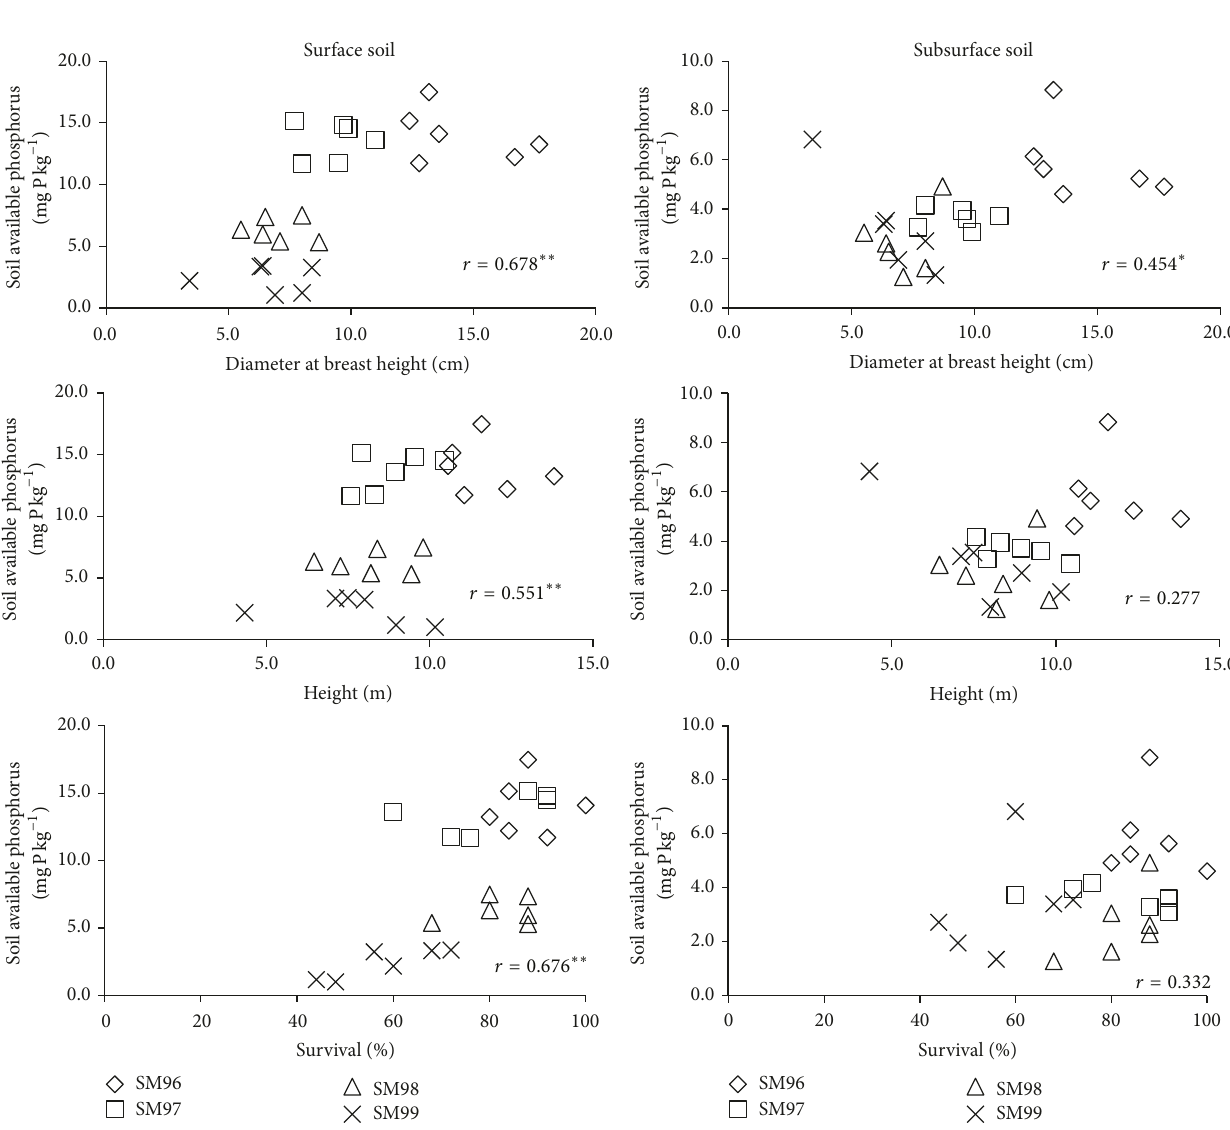
Figure 6: Relationship between soil available phosphorus with diameter at breast height (DBH), height, and percentage of survival derived from surface and subsurface soils. ∗,∗∗ Correlations are significant at 5% and 1% levels, respectively, using Pearson correlation